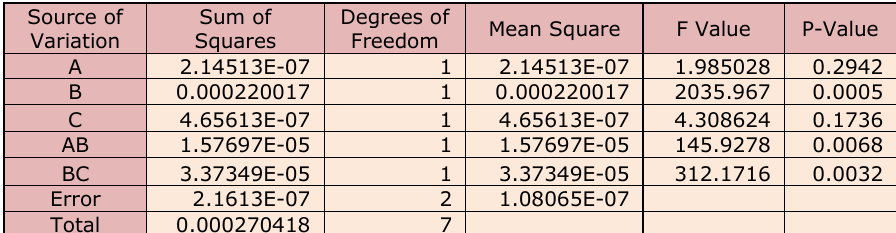
Table 3. Analysis of variance for the medication delivery